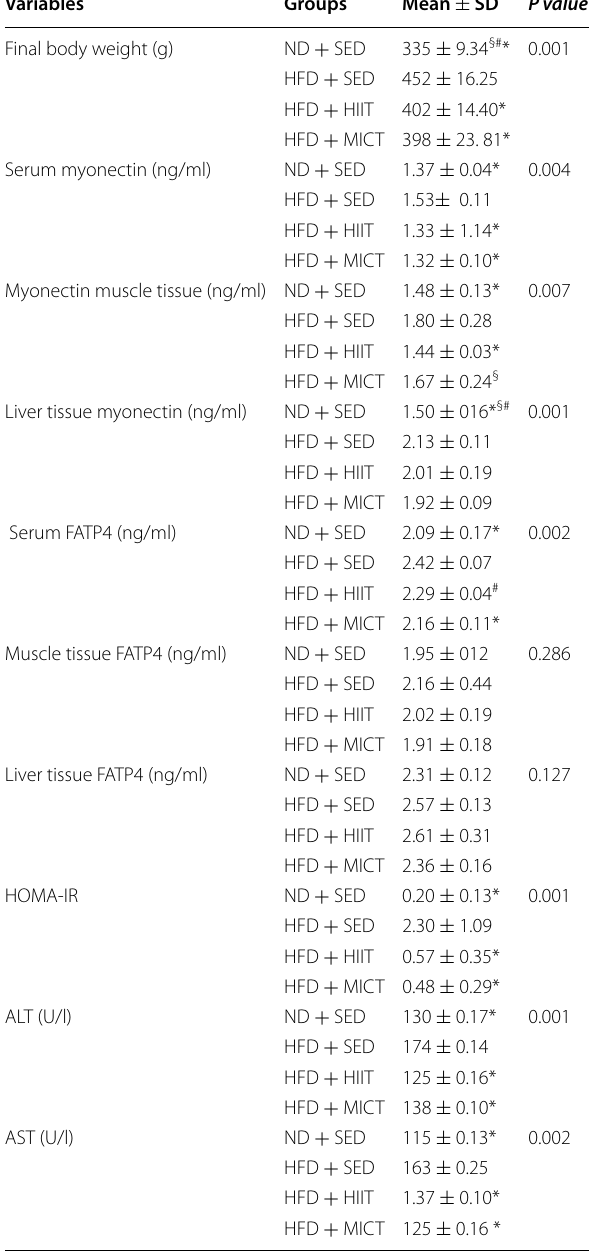
Table 1 The results of one‑way analysis of variance test related to Body weight, ALT, AST, HOMA‑IR, Myonectin and FATP4 among the